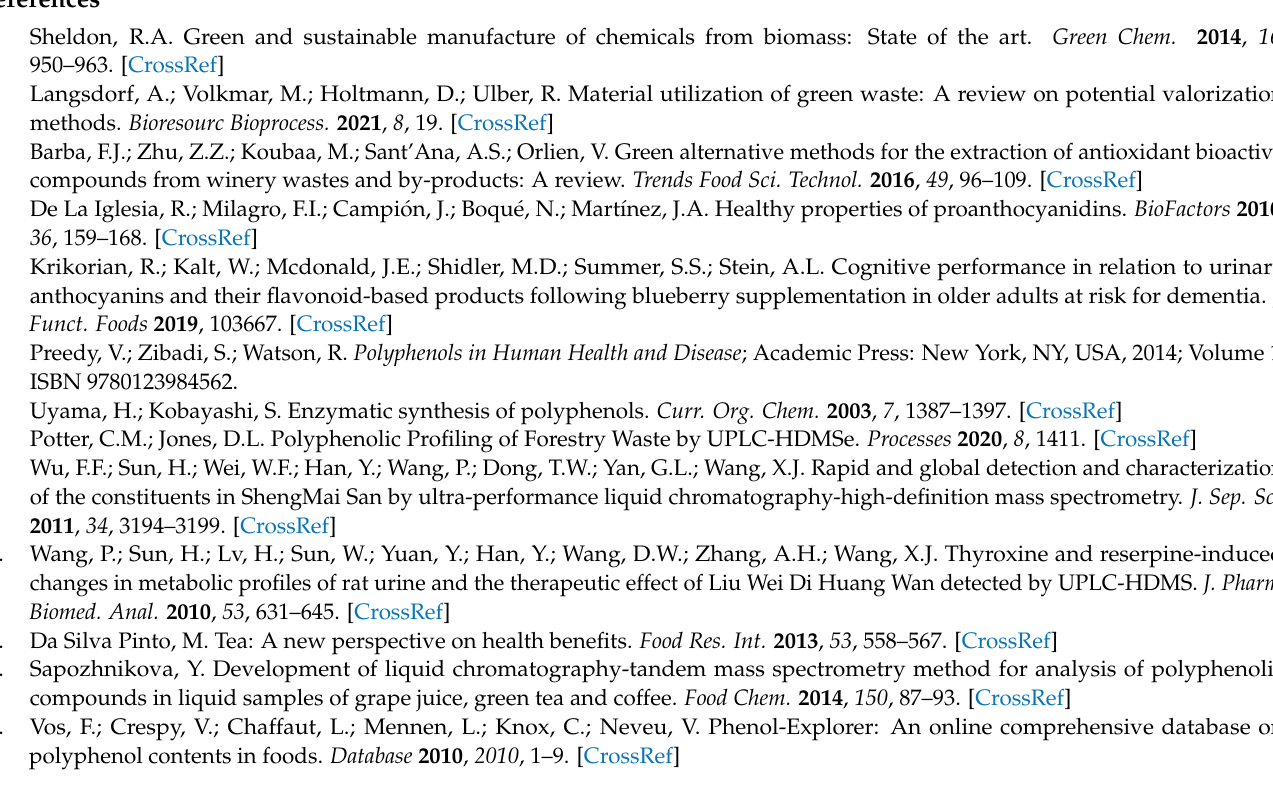
(magenta), Figure S5: Total ion chromatogram of Wild Garlic Leaf (green) and the alignment reference (magenta), Figure S6: Total ion chromatogram of Green Tea (green) and the alignment reference (ma- genta), Figure S7: Molecular structures of identified polyphenolic components, Figure S8: Example mass spectra of identifications ordered from high to low score value, Figure S9: Abundance profile of ( − )-epicatechin (CSID65230), m/z 289.0732, score 38.1, Figure S10: Alexanders, Smyrnium olusatrum, Figure S11: Stinging Nettle, Urtica dioica, Figure S12: Wild garlic, Allium ursinum, Figure S13: